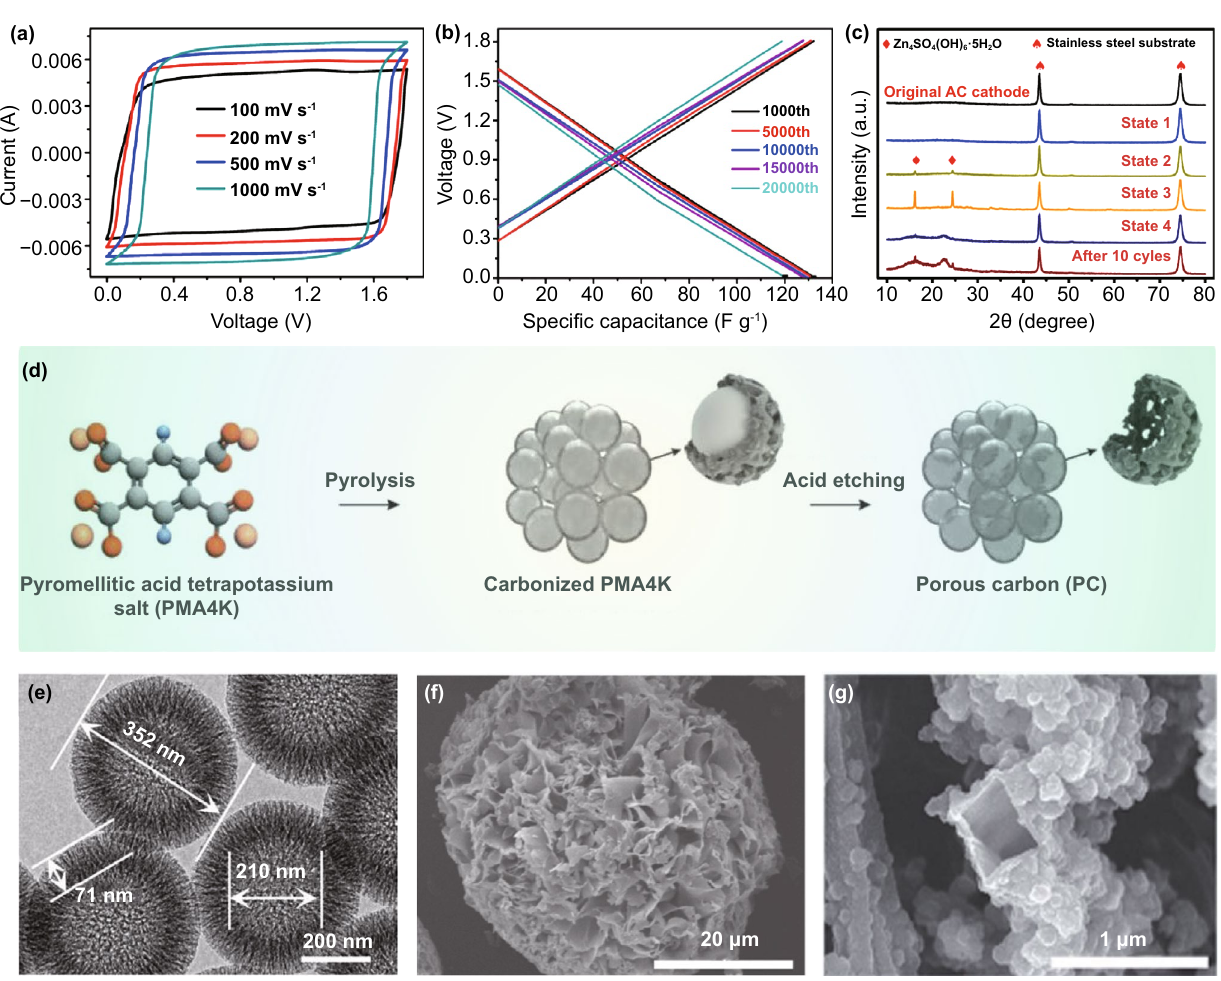
Fig. 4 a CV curves and b GCD profiles of representative Zn//AC ZHSCs. Reproduced with permission from Ref. [101]. Copyright 2018, Else‑ vier. c XRD patterns of AC electrodes at different states. Reproduced with permission from Ref. [31]. Copyright 2018, Elsevier. d Schematic diagram illustrating the synthesis processes of PCs. Reproduced with permission from Ref. [108]. Copyright 2020, Wiley–VCH. e SEM